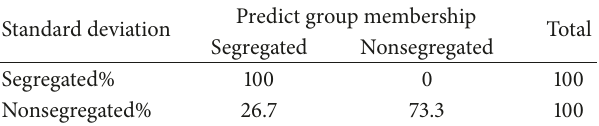
Table 2: Classification results a , b for site location 2.